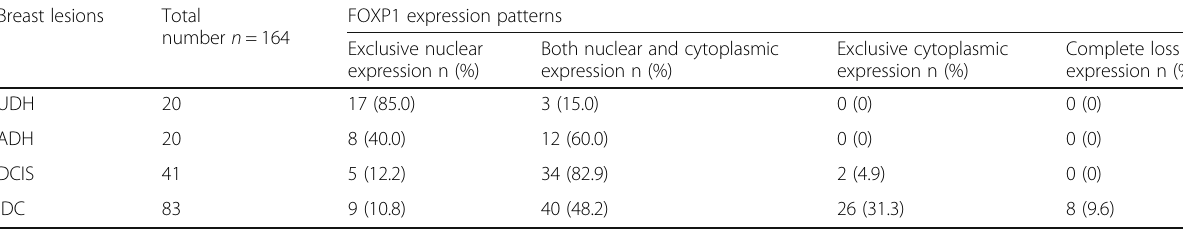
Table 1 FOXP1 protein expression patterns in different breast lesions Breast lesions Total FOXP1 expression patterns number n = 164 Exclusive nuclear Both nuclear and cytoplasmic expression n (%) expression n (%)